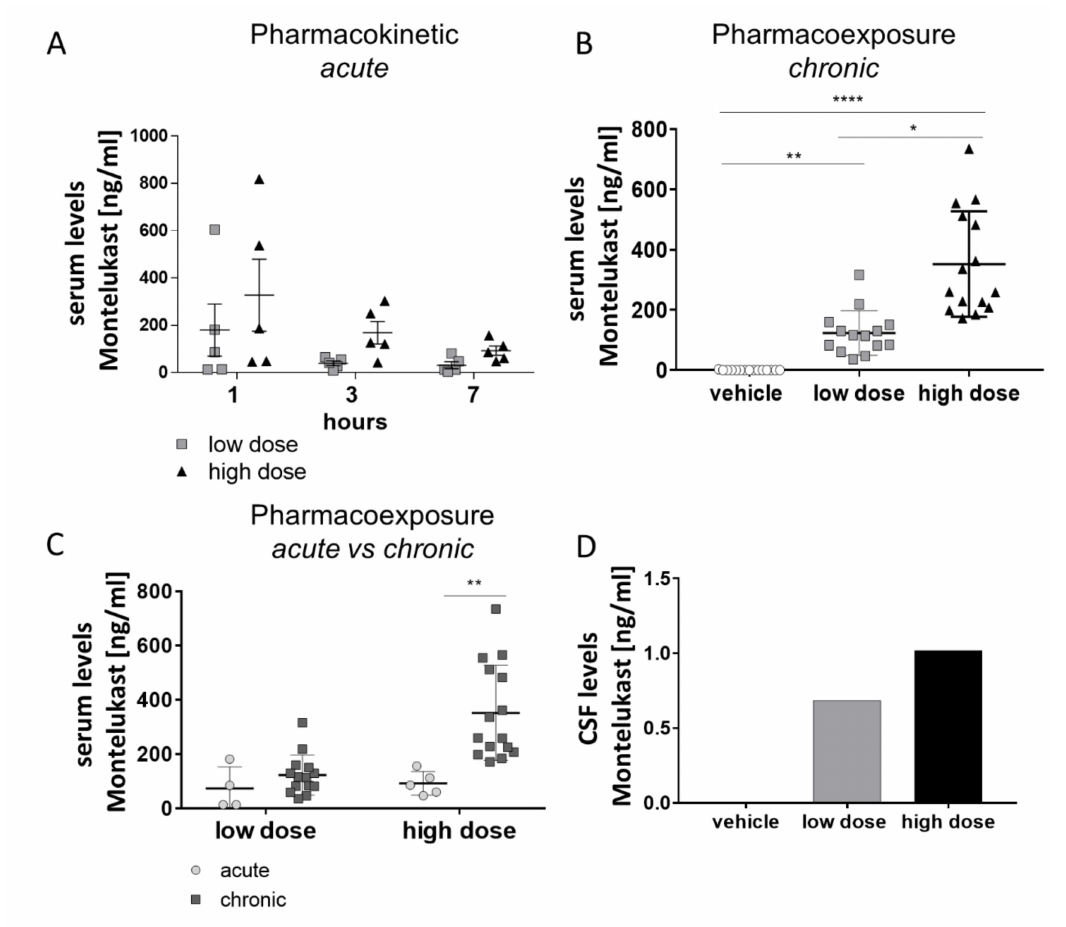
Figure 4. Serum levels of MTK after MTK film application. ( A ) Montelukast (MTK) concentration (high dose = 10 mg/kg/d; low dose = 3.3 mg/kg/d) in the serum decreases over 7 h. ( B ) Samples were taken approximately 7 h after last oral application of MTK by cardiac puncture. Samples were analyzed for MTK concentration by HPLC–MS/MS. There is a dose-dependent increase in serum levels of MTK. ( C ) After long-term treatment the serum concentration of MTK after 7 h is significantly higher than after single dose treatment with a dose of 10 mg/kg/d. ( D ) Pooled samples ( n = 14–15 per group) were analyzed for MTK concentration by HPLC–MS/MS. There is a dose-dependent increase in the MTK concentration in the CSF. Data are shown as mean +/ − SEM. One-way ANOVA with Bonferroni post-hoc test or Student’s t-test was performed. p values of p < 0.0001 and p < 0.001 were considered extremely significant (**** or ***), p < 0.01 very significant (**), and p < 0.05 significant